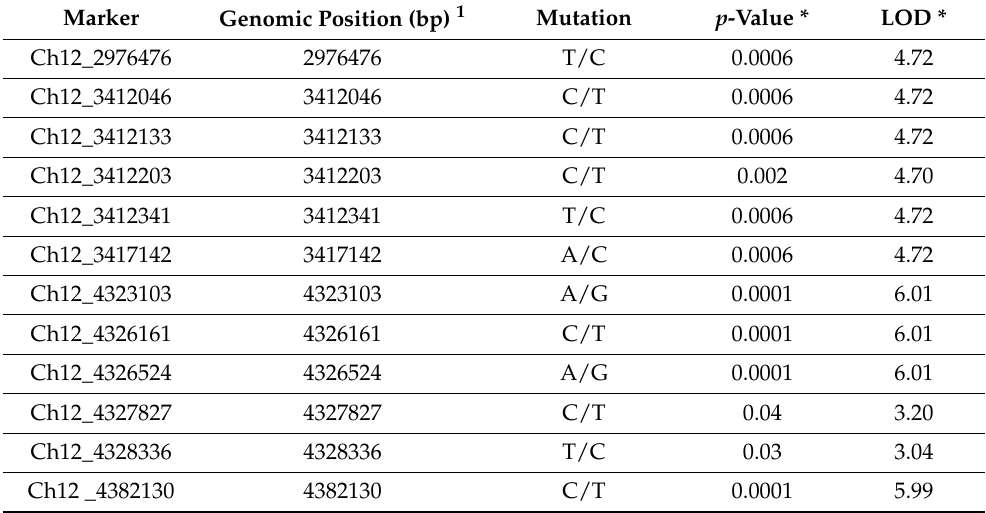
Table 3. Chromosomal (Chromosome 12 (Ch12)) position, p -values and LOD scores of SNP markers tested for association with hull-less seed trait in the individuals constituting the bulks in the F 2 population between Kakai (hull-less) and Table Gold Acorn (hulled). Marker Genomic Position (bp) 1 Mutation p -Value *